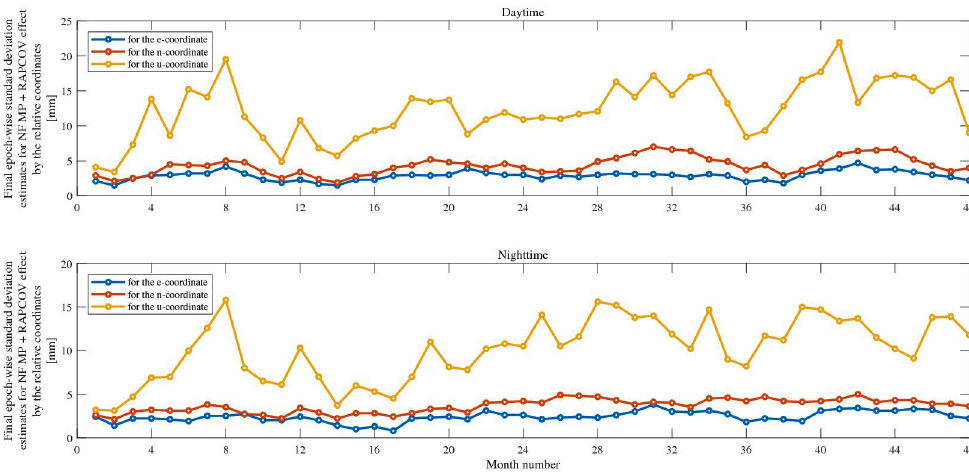
Figure 4. Final epoch-wise standard deviation estimates by the relative coordinates ( e , n and u ) for the joint effect of NF MP and RAPCOV, obtained for the daytime and the nighttime period